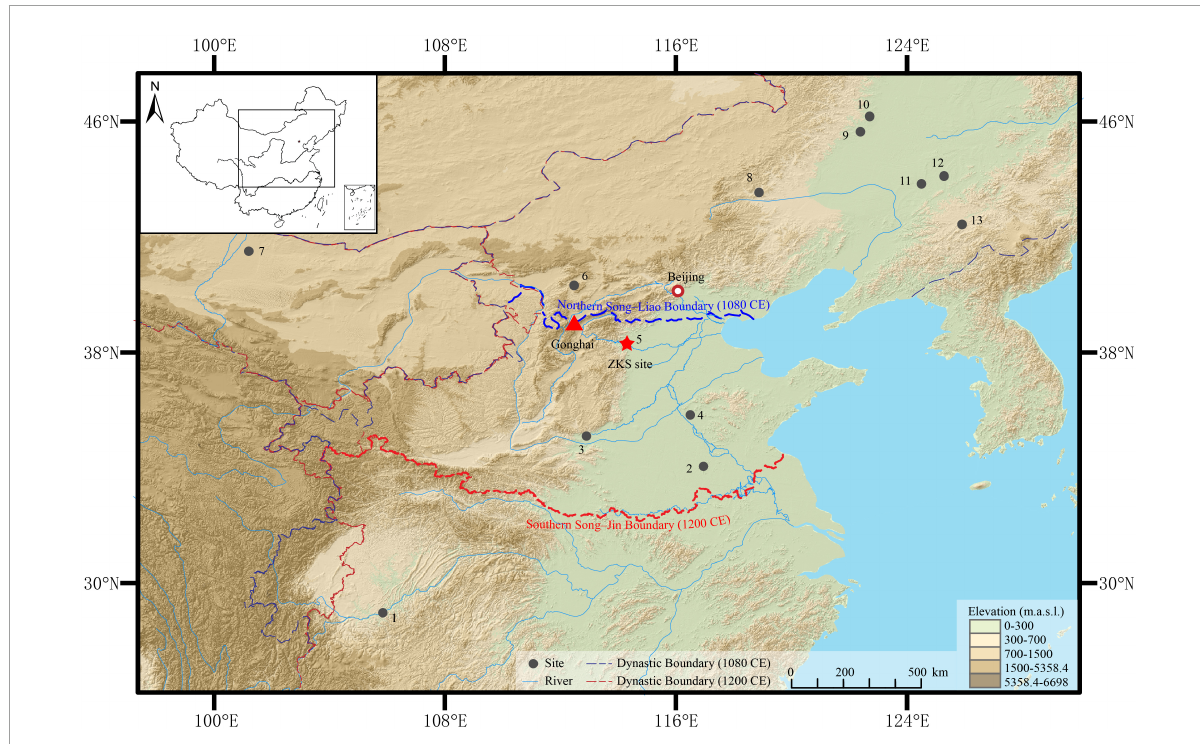
FIGURE1 The location of the study area and the sites mentioned in the text (Digital Elevation Model, http://www.gscloud.cn; approximate shapes of Chinese dynasties https://sites.fas.harvard.edu/~chgis/data): 1. Handong Cheng (Ma et al., 2020); 2. Oupanyao (Bai et al., 2017); 3. Xijincheng (Chen et al., 2010); 4. Liang Zhuang (Wu et al., 2010); 5. ZKS (this study); 6. Zhuangwocun (Zhao, 2020); 7. Heicheng (Shi et al., 2022); 8. Bayantala (Sun and Zhao, 2014); 9. Sun Changqing (Yang et al., 2010a); 10. Yongping (Yang, 2014a); 11. Changshan (Chen, 2019); 12. Lichunjiang (Yang et al., 2010b); 13. Luotongshancheng (Yang,